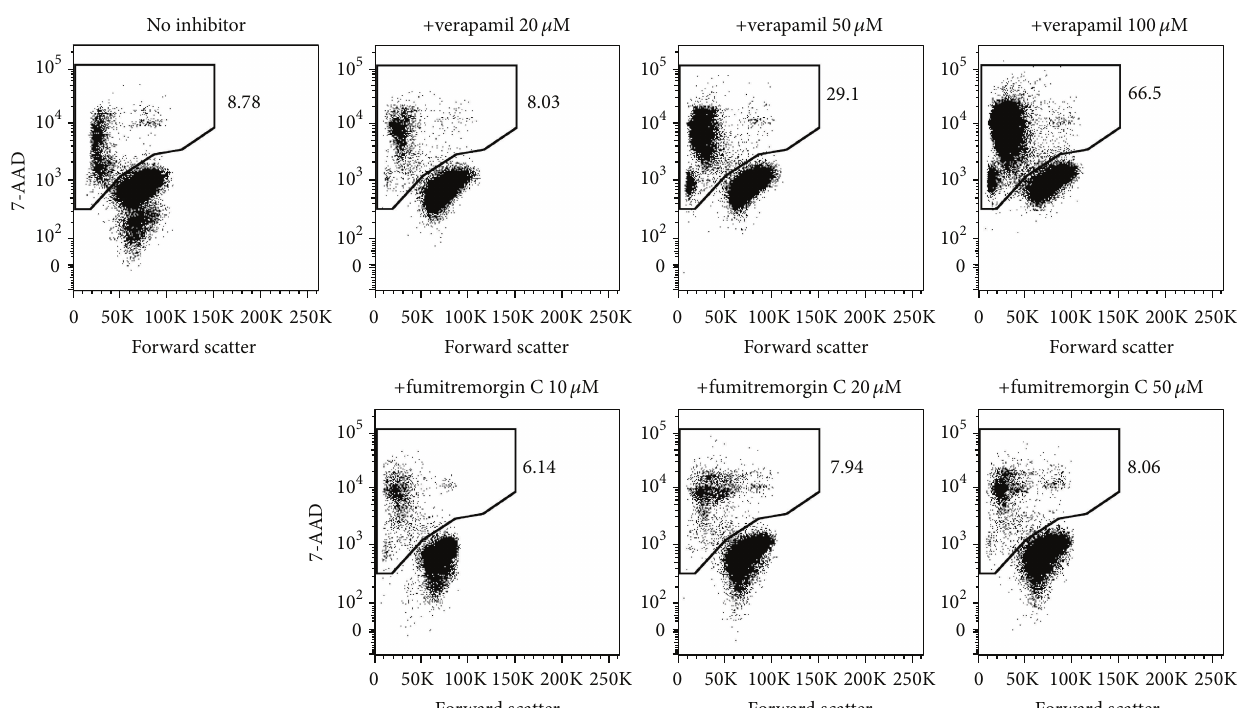
Figure 5: Evaluation of cell death induction by pharmacological inhibitors of drug transporter activity. A2780V cells (10 6 cells/mL) were stained with 10 𝜇 M DCV. Control aliquots containing different concentrations of inhibitor (either verapamil or fumitremorgin C) were prepared thereof and analysed for cell viability using 7-AAD staining. Verapamil induces significant cell death already at the commonly used dose of 50 𝜇 M, whereas the ABCG2-specific inhibitor fumitremorgin C leaves the cells virtually